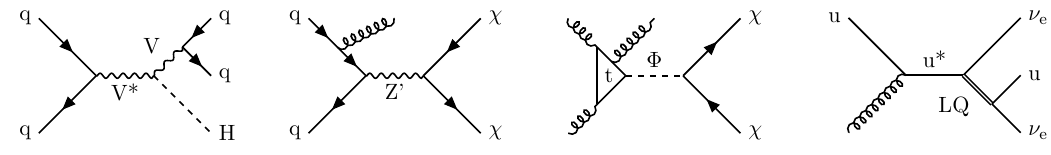
Figure 1 . Representative Feynman diagrams for a number of signal models: Higgs production in association with an SM vector boson (left), colorless spin-1 and spin-0 mediators (middle left and right, respectively), single leptoquark production (right). In all cases, subdominant production modes not pictured here are taken into account, as described in the